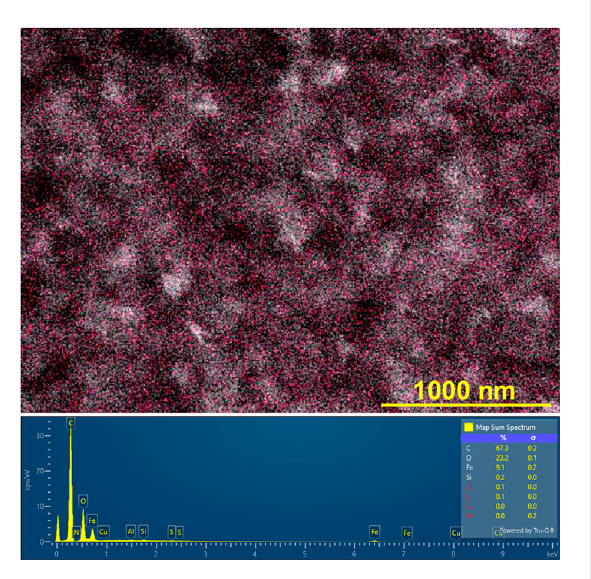
FIGURE 10 (Top) Scanning electron microscope ( SEM) image (× 40,000) of the rust-brown band formed in the gel columns with L = 50 mm at 25 ° C under the following applied cyclic alternating voltages: E H = 3 V, E T T N α intensity L = 1 V, H = 1 h, L = 4 h, and C = 8. Here, the Fe L map (the observed positions are shown as pink dots) is overlapped, and a scale bar is provided on the lower right part of the image. (Bottom) X-ray fl uorescence (XRF) spectrum, where all the measured XRF intensities have been added over the area of the above SEM image. The estimated weight % values of the detected elements are tabulated on the right side of this